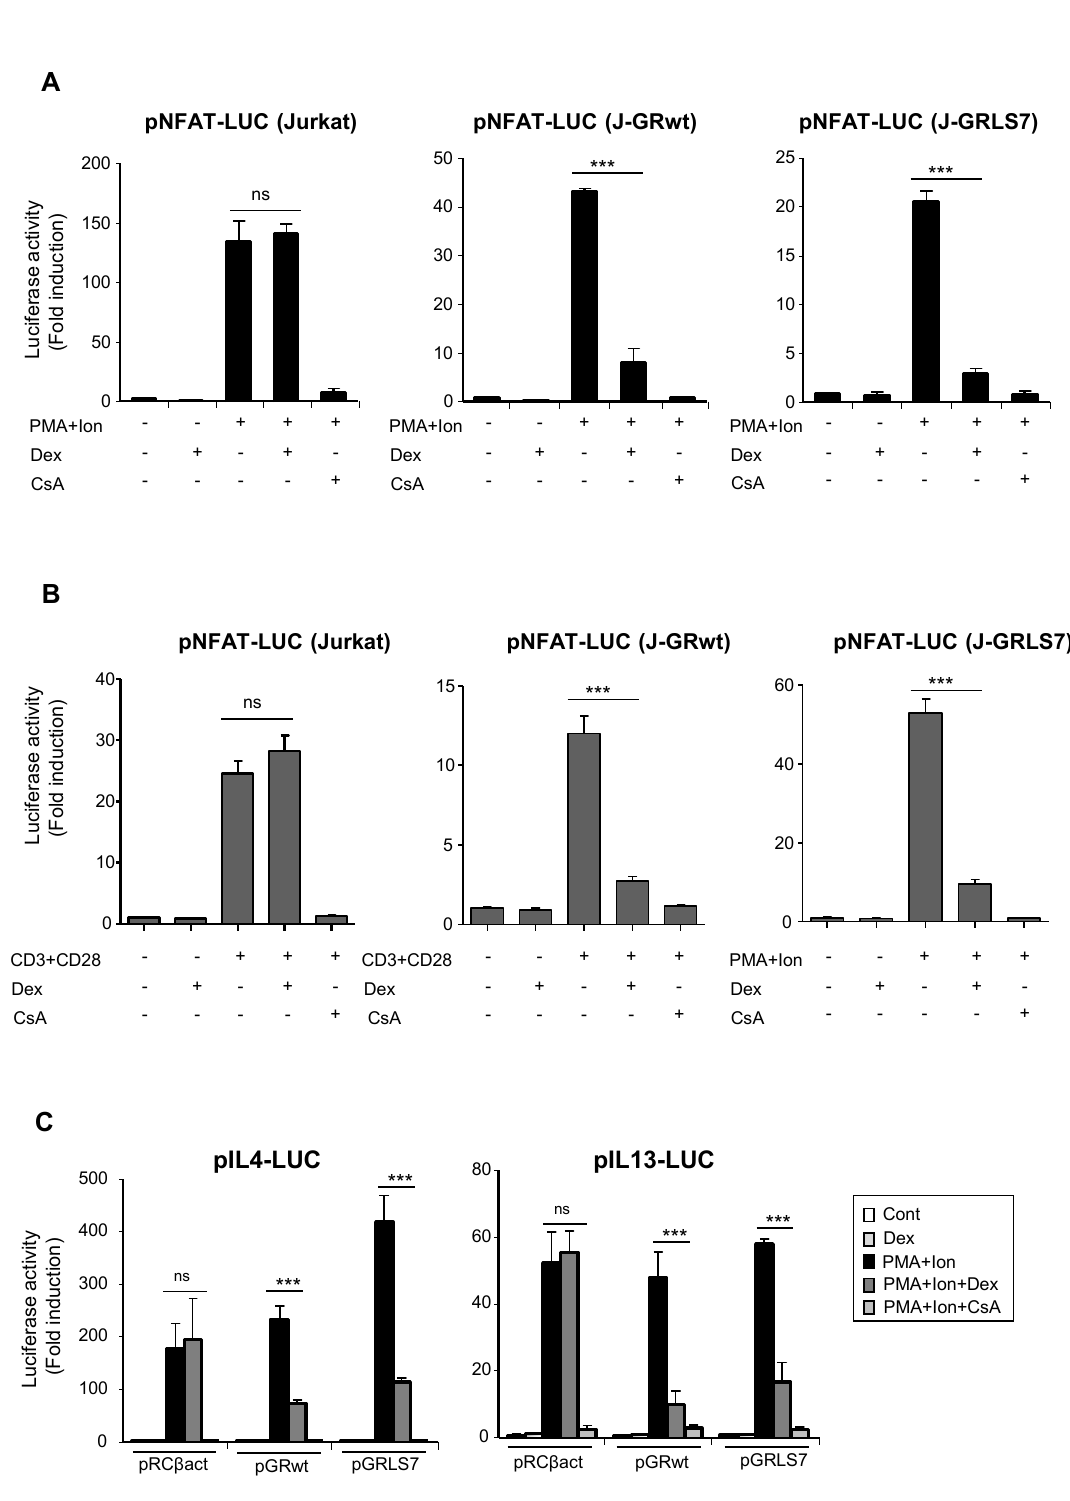
Figure 4. Dex reduces NFAT-mediated transcriptional activity in Jurkat T cells in the presence of GR or GRLS7. Transfected cells were pre-treated or not with Dex (1 μ M) or CsA (100 ng/mL) before stimulation with PMA + Ion (15 ng/mL +1 μ M) or with anti − CD3/CD28 Abs (5 μ g/mL; 1 μ g/mL). ( A,B ) Parental, J − GRwt, and J − GRLS7 Jurkat cells were transiently transfected with the luciferase reporter construct pNFAT − Luc and treated as indicated. Results shown are from a representative of three independent experiments performed in triplicate, and are expressed as fold induction mean ± SEM. ns: non-significant; *** p < 0.001; vs. PMA + Ion (in A ) or CD3/CD28 treatment (in B ). ( C ) Jurkat cells were co-transfected with luciferase reporter plasmids containing IL4 or IL13 promoter regions along with empty plasmid (pRC β act) or expression vectors for GRwt or GRLS7. Results are repre- sented as fold induction (PMA + Ion over unstimulated control samples) (mean ± SEM). (*** p < 0.001